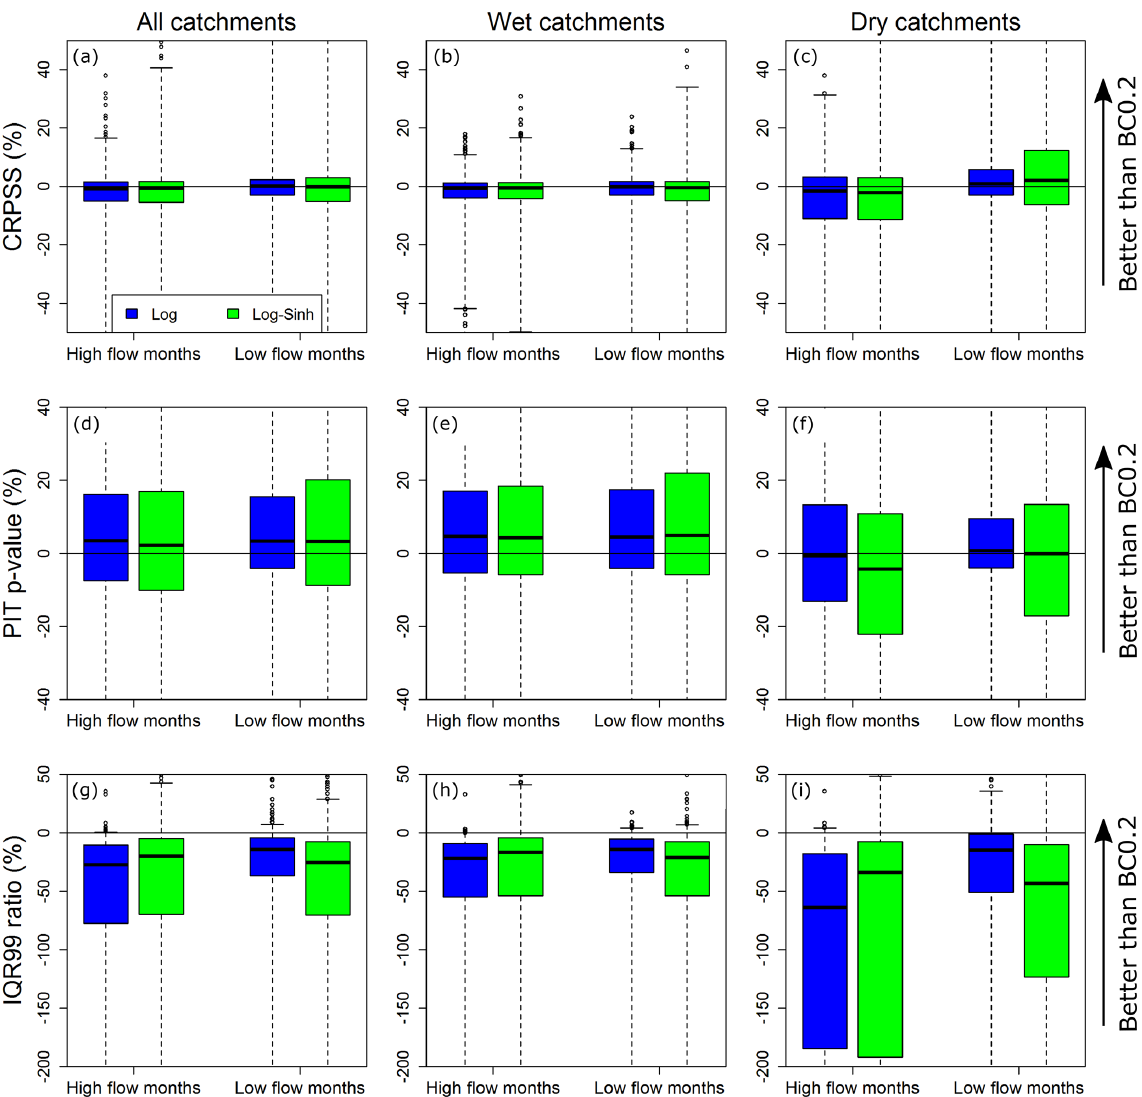
Figure 6. Distributions of differences in the monthly forecast performance metrics of the Log and Log-Sinh schemes compared to the BC0.2